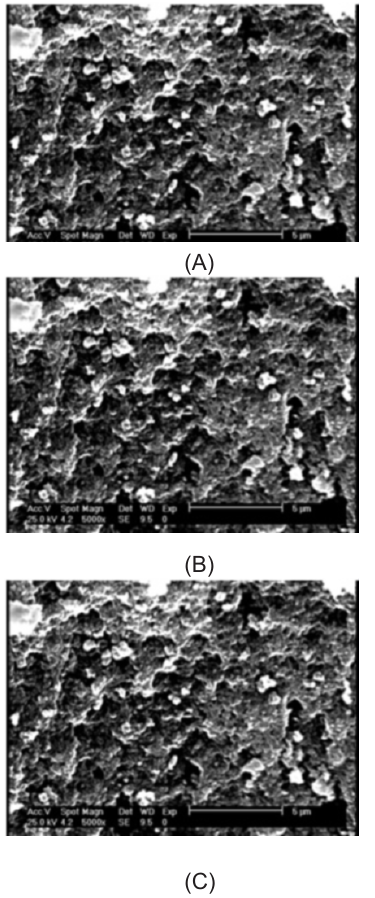
Figure 6. Recovered samples obtained using the MIP and NMIP polymers synthesized in different organic solvents. Batch experiments with 50 mg or polymer particles; sample volume, 5 mL; pH, 7.5; tramadol concentrations, 50 µgL −1 (mean±S.D.,